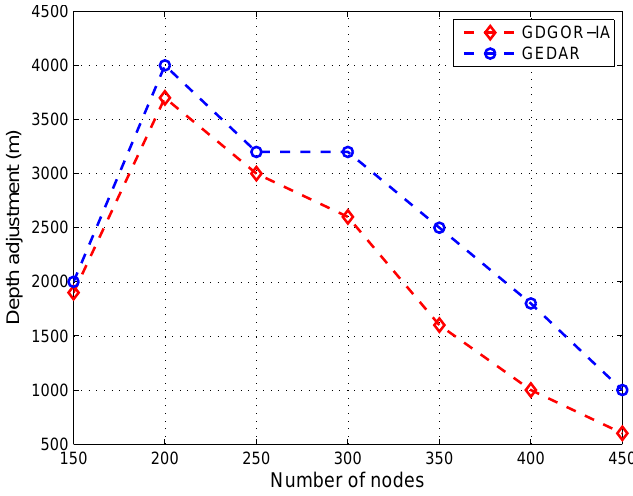
Figure 9. Depth adjustment